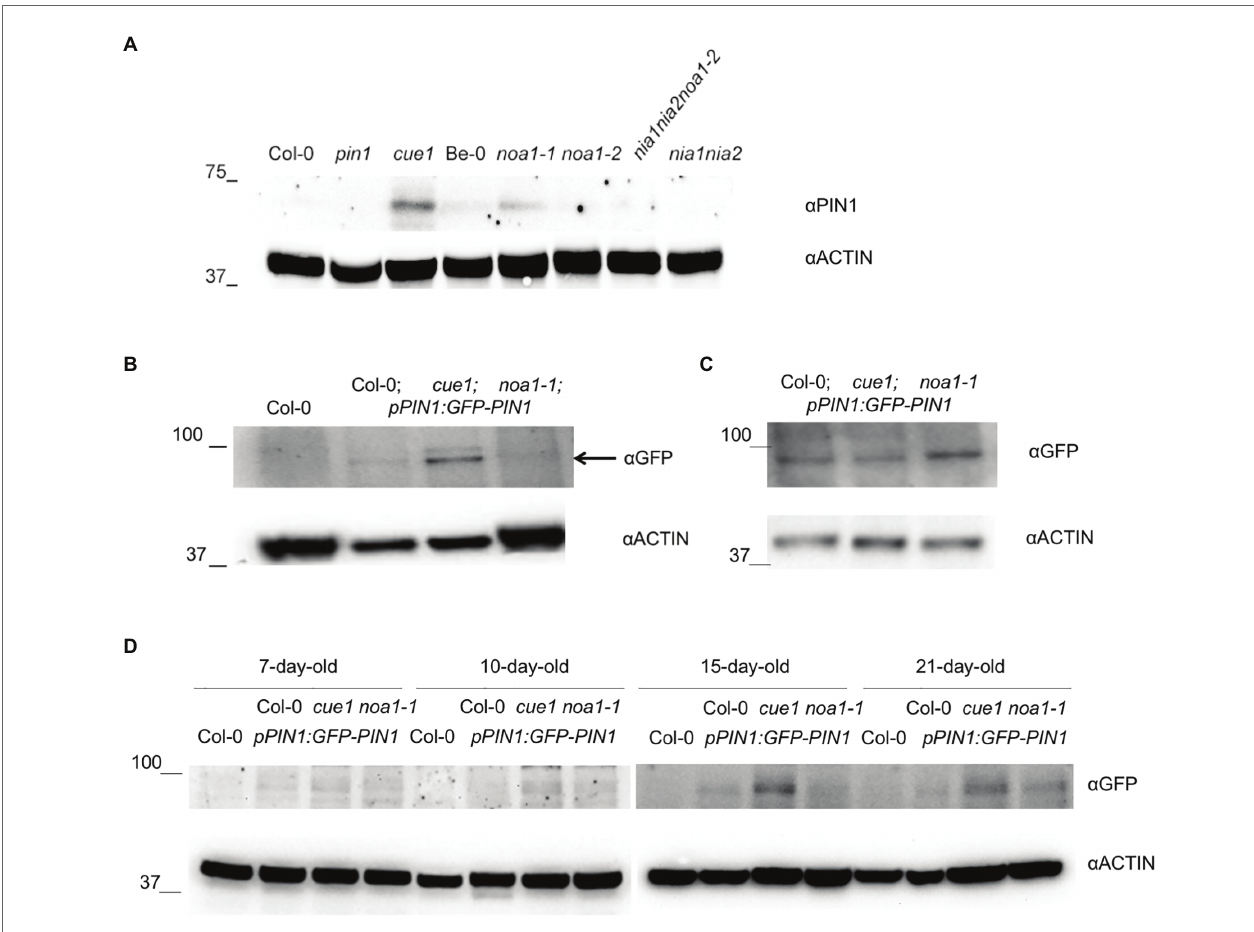
FIGURE 6 | Effect of NO homeostasis mutants on PIN1 protein accumulation. Immunoblot analysis with anti-PIN1 in 30-day-old, A. thaliana rosette leaf extracts grown on soil from Col-0, pin1 , cue1/nox1 , noa1-1 , noa1-2 , nia1nia2noa1-2 , and nia1nia2 mutants (A) . Immunoblot analysis with anti-GFP in 21-day-old leaf extracts from Col-0 and pPIN1:PIN1-GFP transgenic lines in Col-0, cue1/nox1 , and noa1-1 backgrounds (B) . Black arrow indicates PIN1-GFP quimeric protein detection. (C) Immunoblot analyses with anti-GFP antibody in 15-day-old Arabidopsis root extracts from pPIN1:PIN1-GFP transgenic lines in Col-0, cue1/nox1 , and noa1-1 backgrounds grown on MSR. Actin protein levels were also determined as loading control. (D) Immunoblot analysis with anti-GFP in Col-0 and pPIN1:PIN1- GFP transgenic lines in Col-0, cue1/nox1 , and noa1-1 backgrounds using 7-, 10-, 15-, and 21-day-old rosette leaf extracts grown in vitro . Actin protein levels were also determined as loading